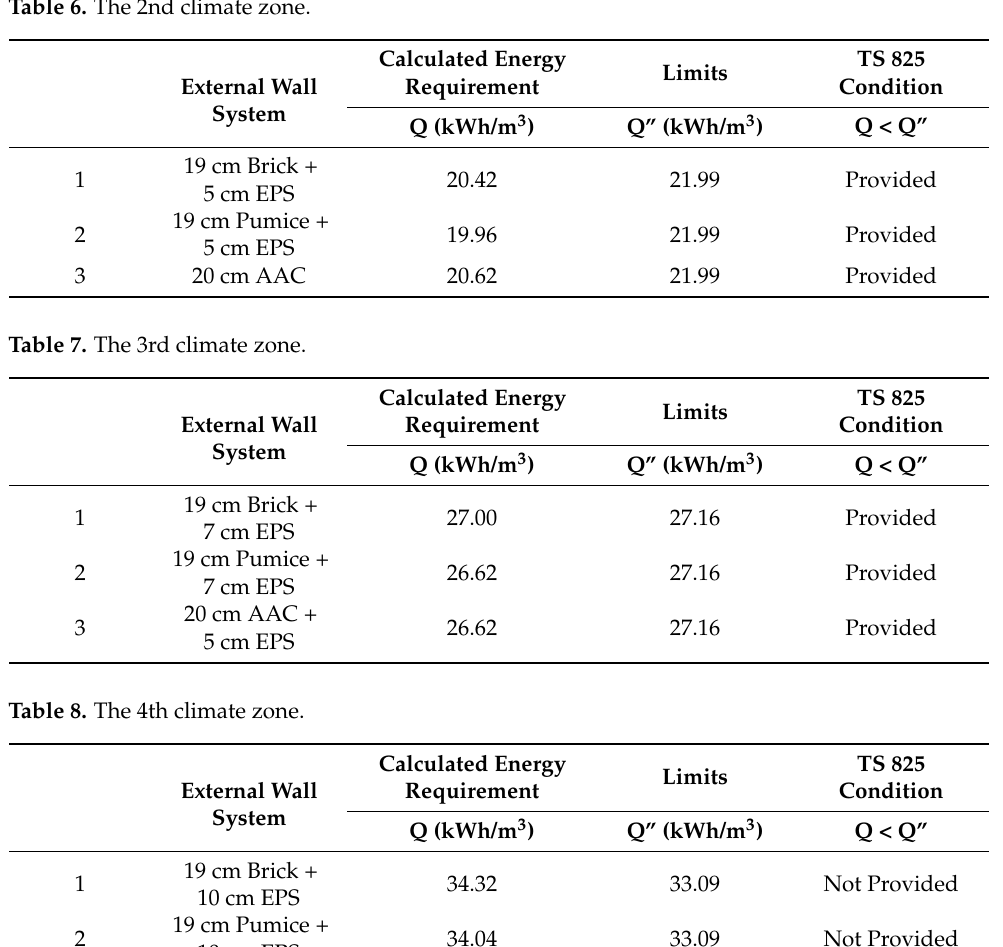
Table 6. The 2nd climate zone.